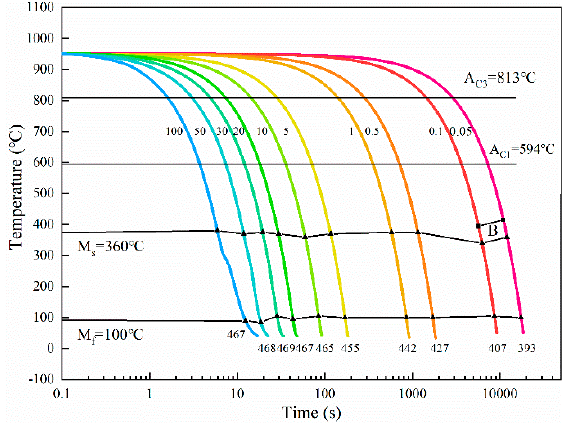
Figure 1. Measured continuous cooling transformation (CCT) diagram of the experimental steel.